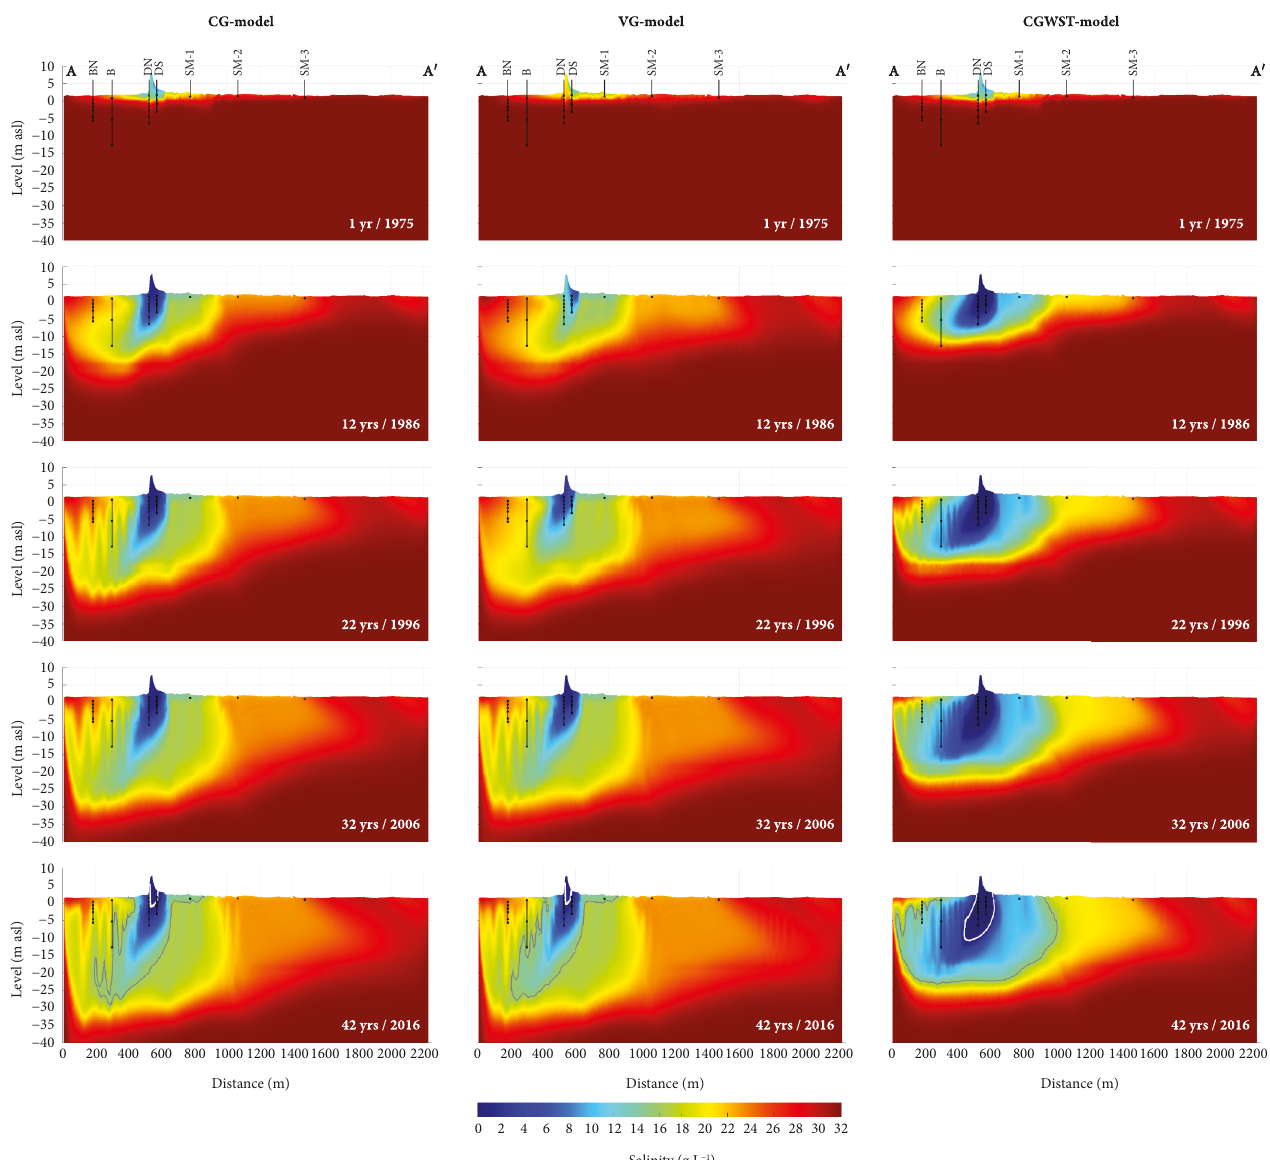
Figure 4: Temporal evolution of the groundwater salinity distribution and FWL along cross-section A-A ’ for the CG- (left column), VG- (central column), and CGWST-model (right column). Model results are presented for various simulation times, with the present situation after 42 years at the bottom row. The 1 gL -1 (white line) and the 16gL -1 (i.e., 50% seawater, gray line) contour lines, respectively, are displayed for the present situation. Note that the salinities represent the distribution before storm tides occur at the end of each respective